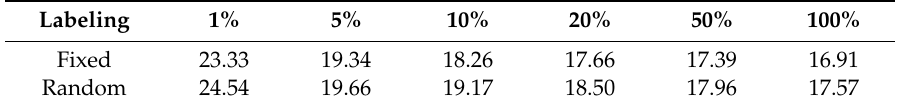
Table 2. FD001 root mean square error (RMSE) Unsupervised feature learning with semi-supervised regression.